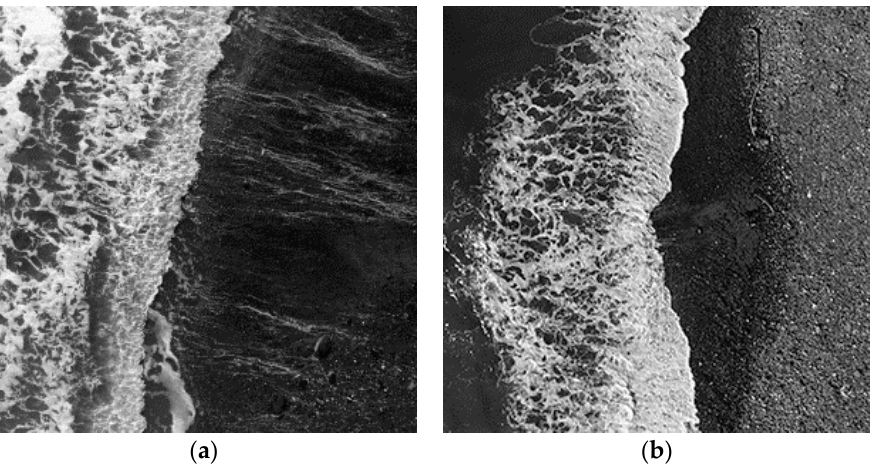
Figure 1. ( a , b ) Two examples of the initial drone images, taken at approximately 45ft altitude. Source: